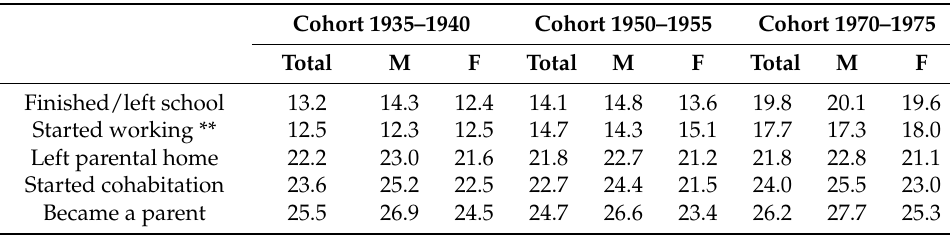
Table 3. Mean age at transitions per gender